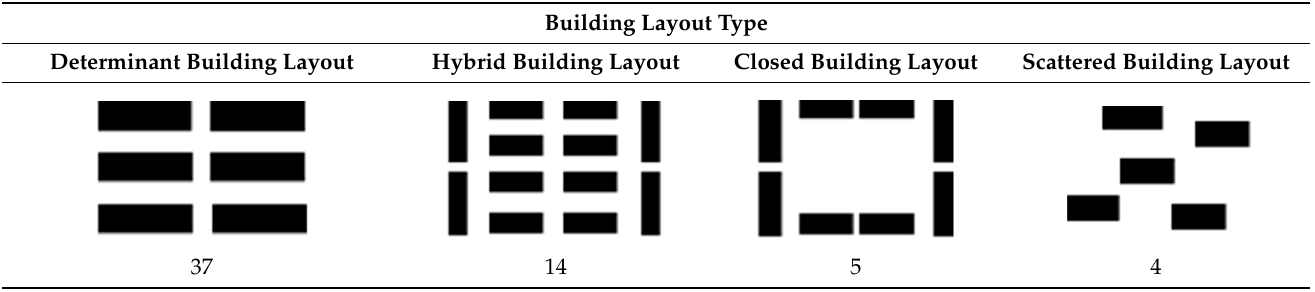
Table 1. Architectural layout characteristics of residential areas in Lhasa.